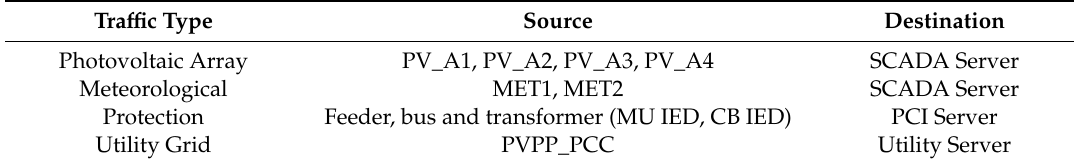
Table 7. Tra ffi c configuration of the PV power plant.